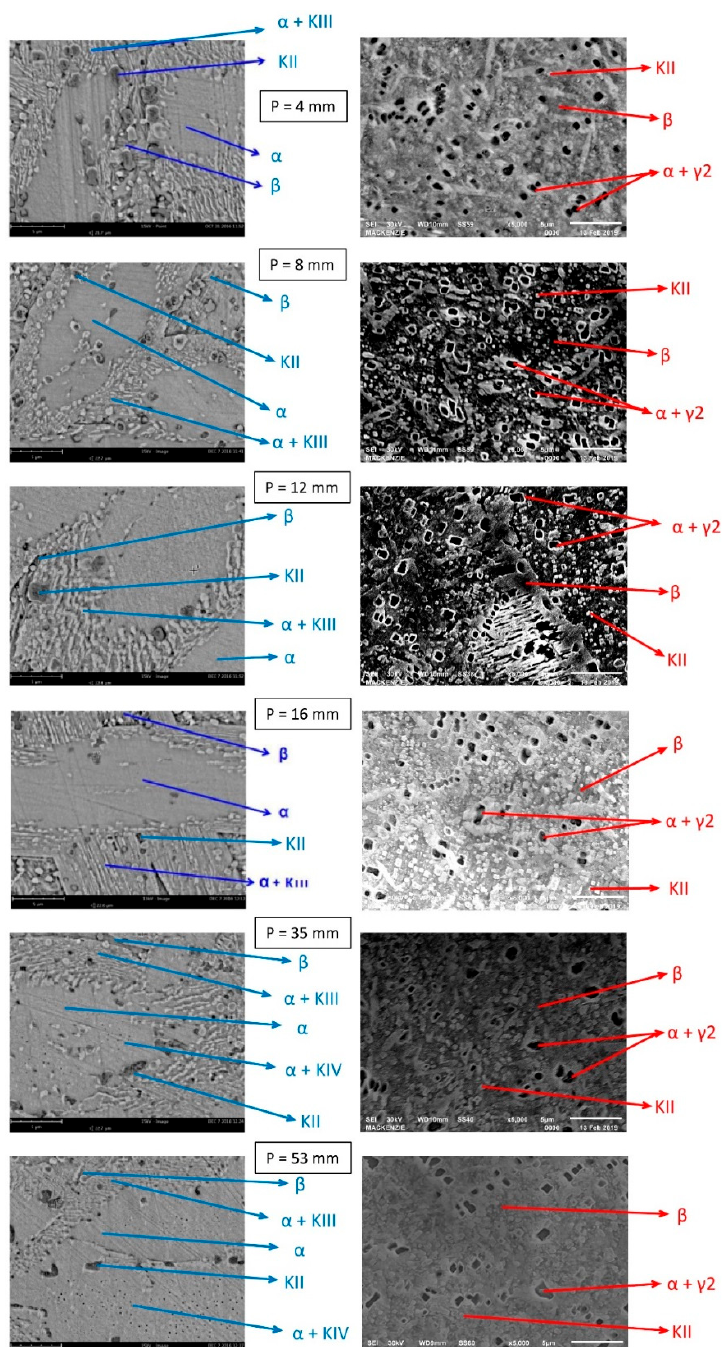
Figure 8. Scanning electron microscopy (SEM) analysis of the various samples taken from different positions (P) as a function of the heat exchange surface: ( left ) Cu10Al alloy; and ( right ) Cu14Al alloy.